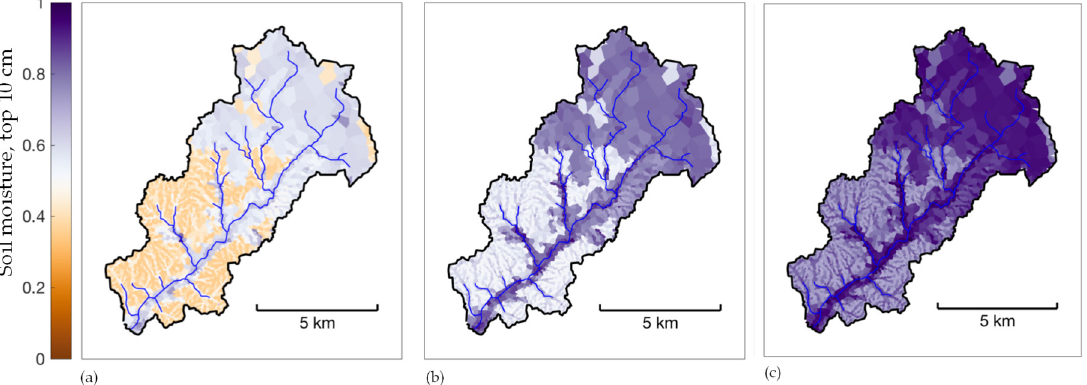
Figure 7. Examples of synthetic initial basin states with an average MSM10 value within the basin of ( a ) 0.5 ( b ) 0.6 and ( c ) 0.7. The color bar represents the values of soil moisture in the top 10 cm for the different voronoi polygons.